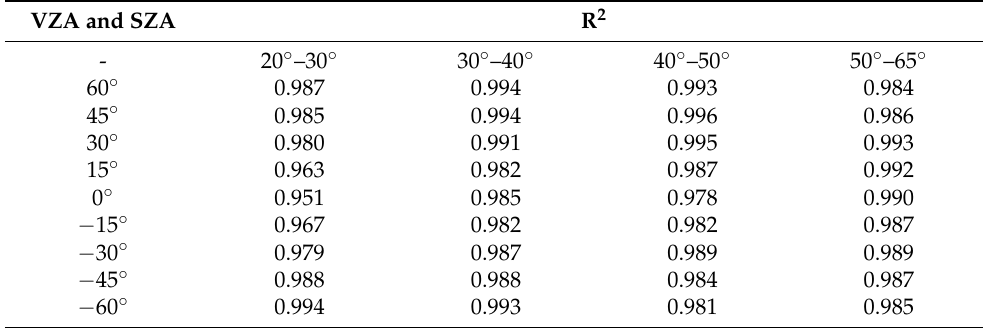
Table 3. The R 2 values of SZA